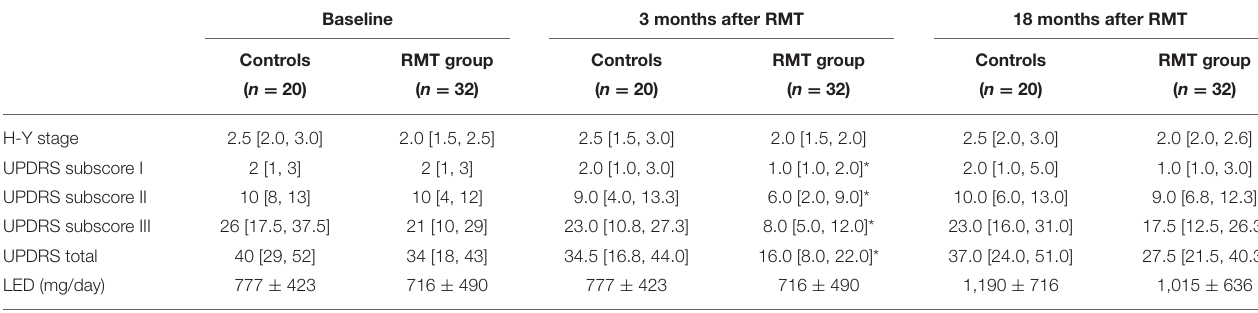
TABLE 3 | Comparison of serial changes of functional scores between two groups.